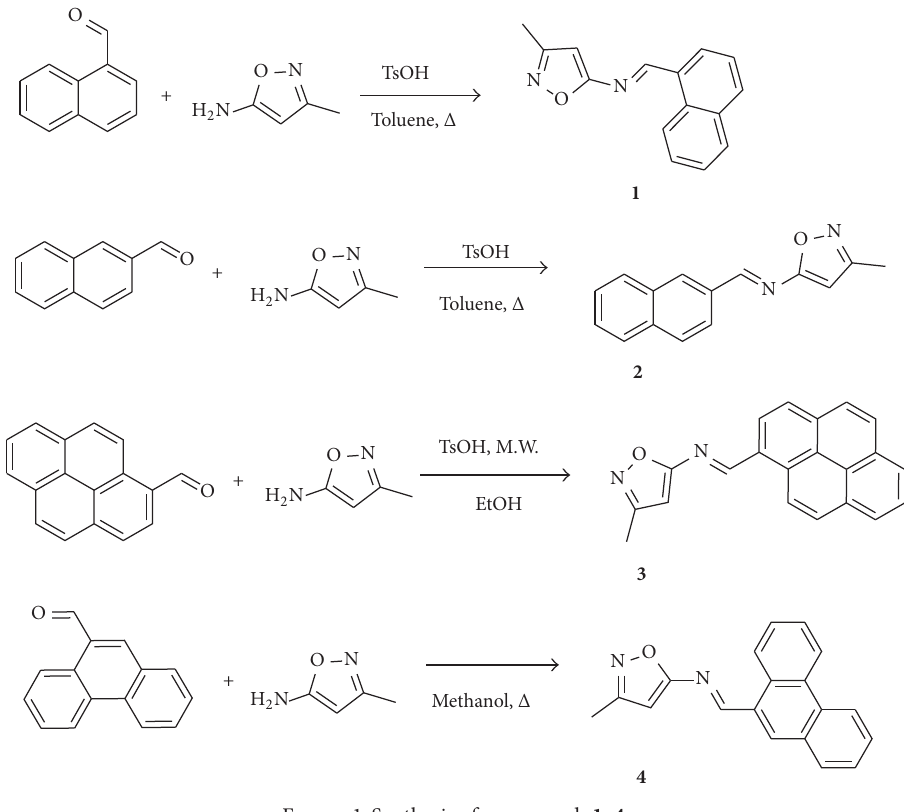
Figure 1: Synthesis of compounds 1 – 4 .